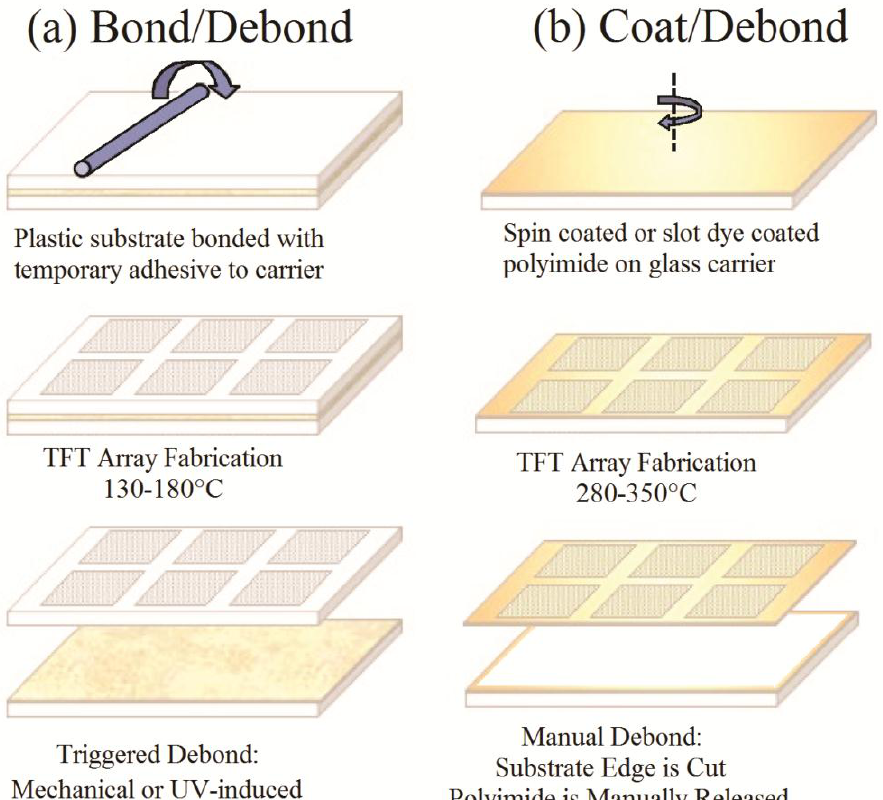
Figure 2. Bond/debond and polyimide coat/debond process flow. TFT: thin film transistor.